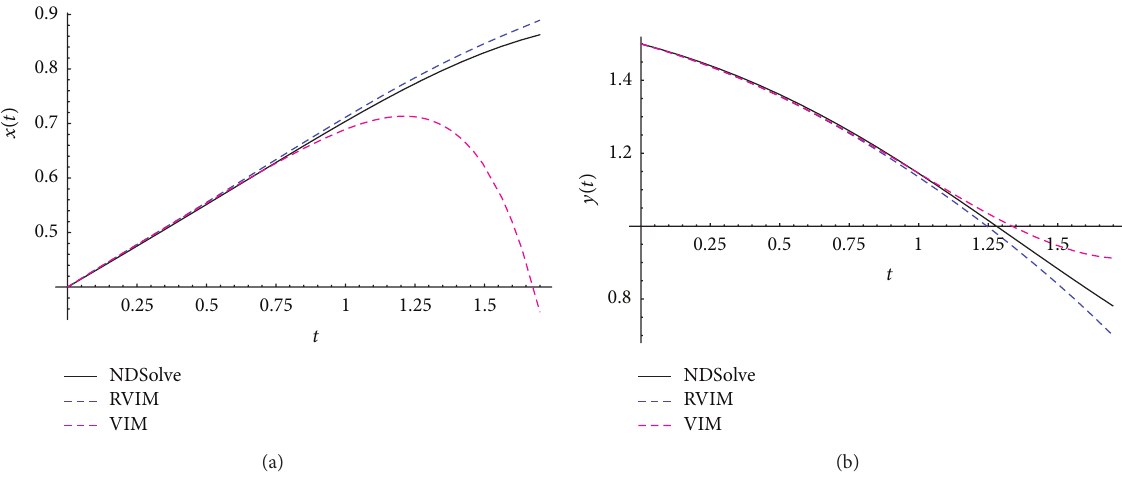
Figure 3: Simulation of the approximate results for 𝛼 1 = 𝛼 2 = .98 and exact solution for 𝛼 1 = 𝛼 2 = 1 of the Brusselator system.